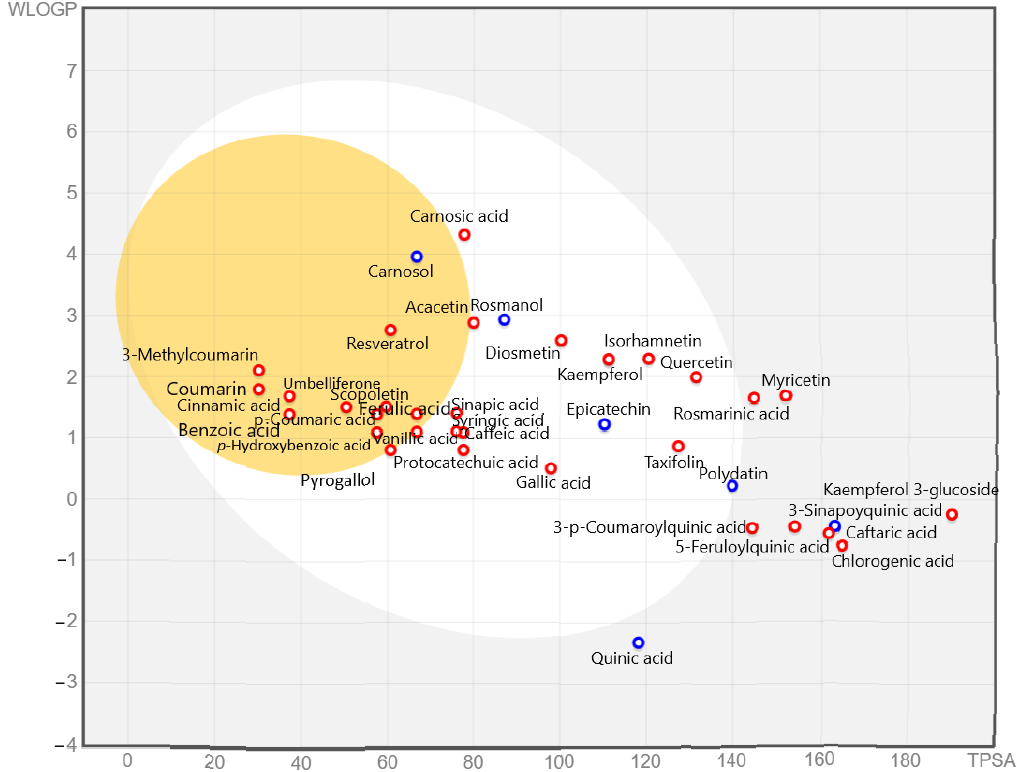
Figure 4. Boiled ‐ Egg method for the evaluation of absorption of abundant phenolic compounds. Figure 4. Boiled-Egg method for the evaluation of absorption of abundant phenolic compounds. The The blue dots indicate molecules predicted to be effluated from the CNS by P ‐ glycoprotein, and the blue dots indicate molecules predicted to be effluated from the CNS by P-glycoprotein, and the red red dots indicate molecules predicted not to be effluated from the CNS by P ‐ glycoprotein. The egg dots indicate molecules predicted not to be effluated from the CNS by P-glycoprotein. The egg yolk area predicts the phenolic compounds that passively penetrate the blood–brain barrier (BBB). The egg white area predicts which phenolic compounds have been absorbed through the gastrointestinal